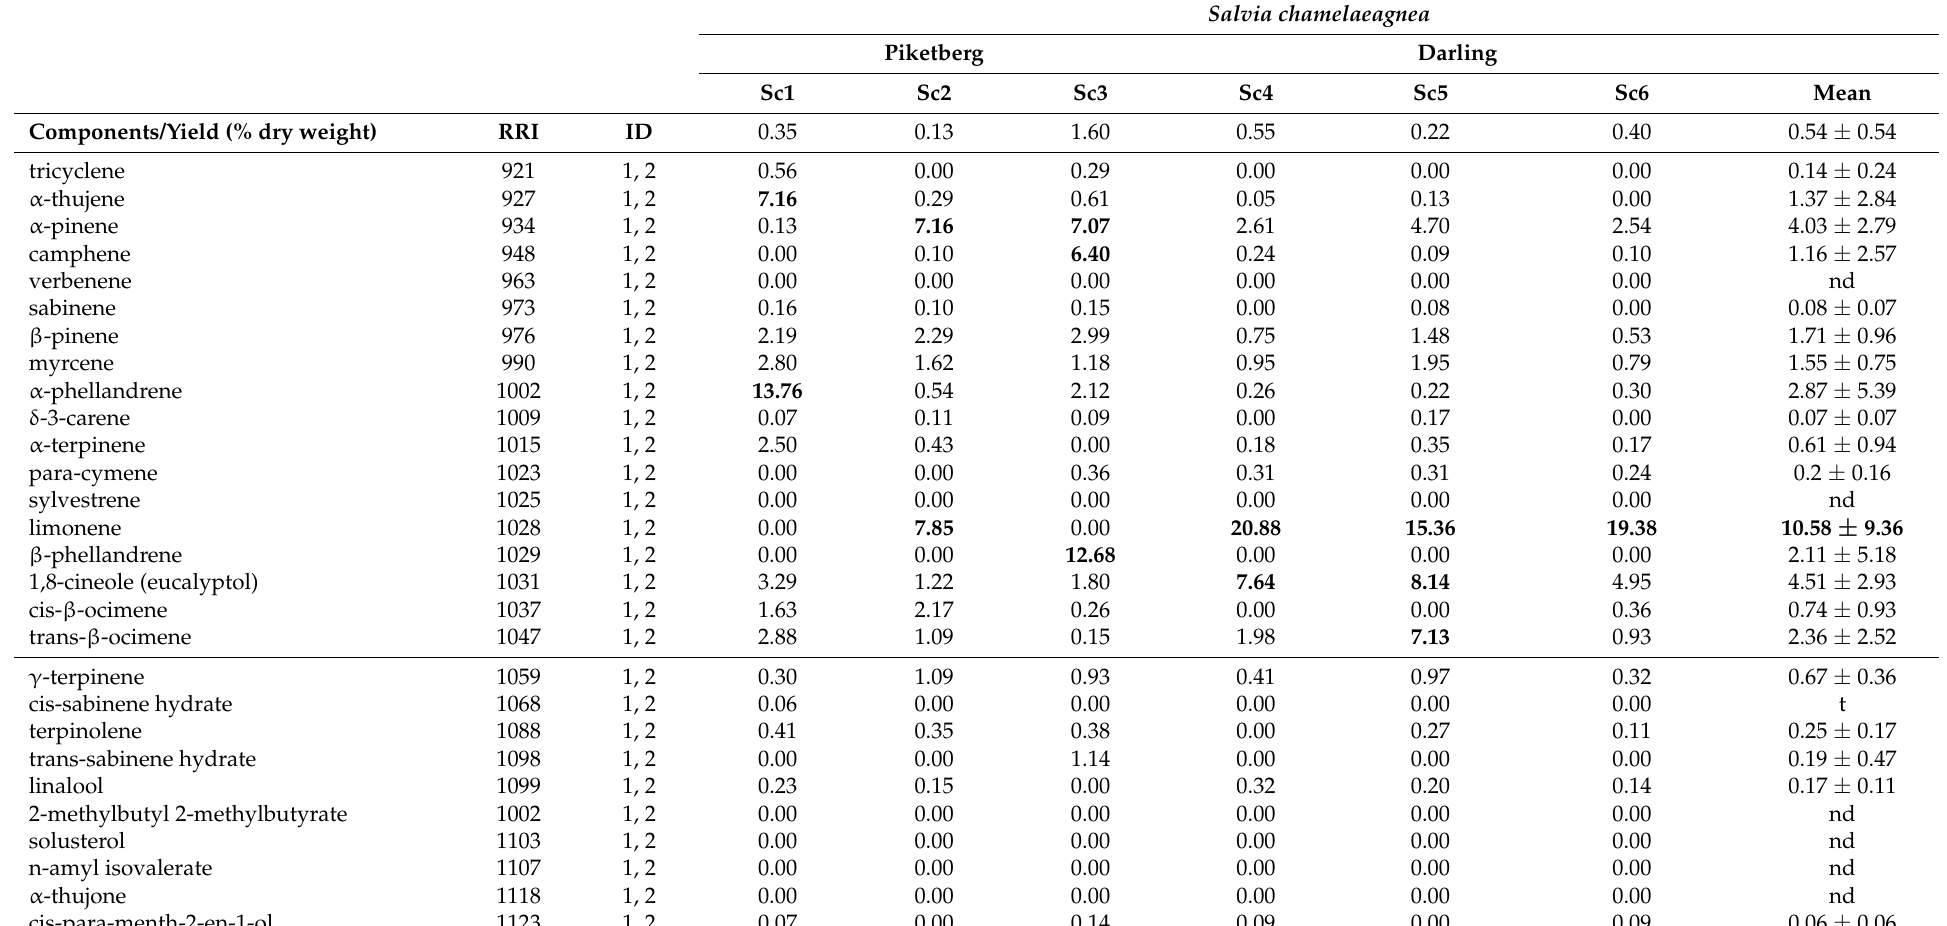
Table 4. Identified essential oil components (%) of Salvia chamelaeagnea